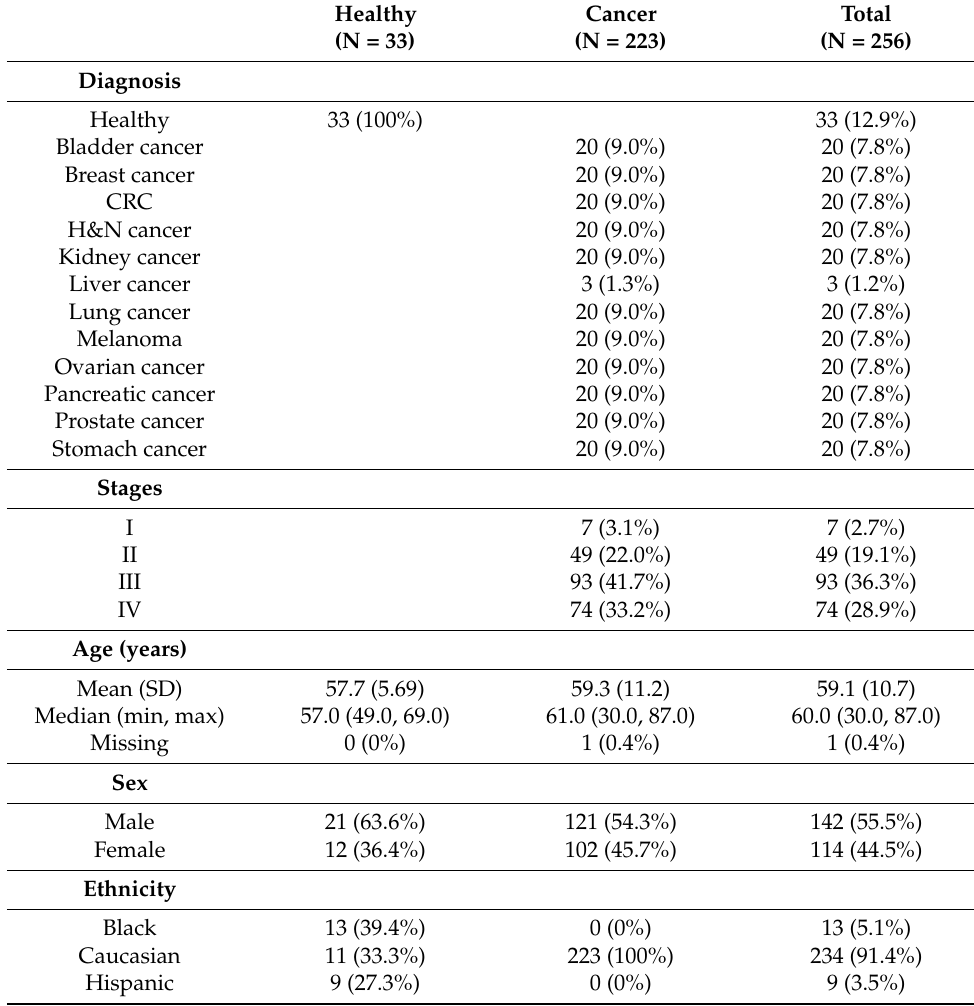
Table 4. Cohort demographics of cancer patients and healthy